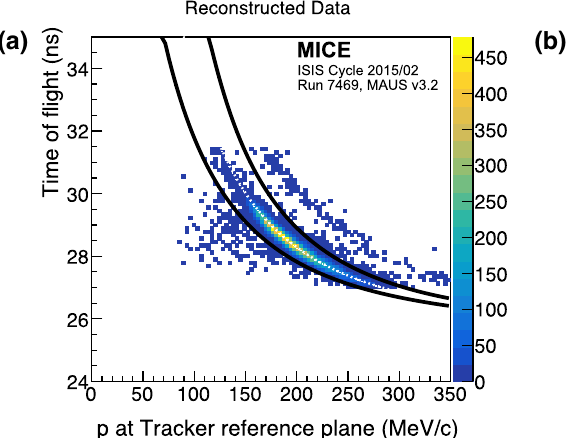
Fig. 4 Time of flight between TOF0 and TOF1 ( t 01 ) plotted as a func- tion of the muon momentum, p , measured in the upstream tracker. All cuts other than the muon hypothesis have been applied. Particles within the black lines are selected. The white dotted line is the trajectory of